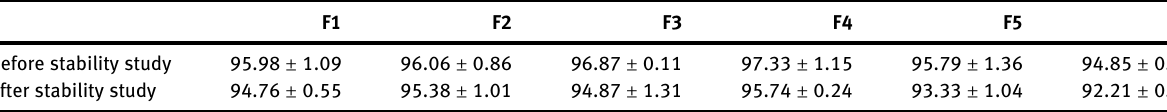
Table  : Drug content of different formulations before and after stability studies.